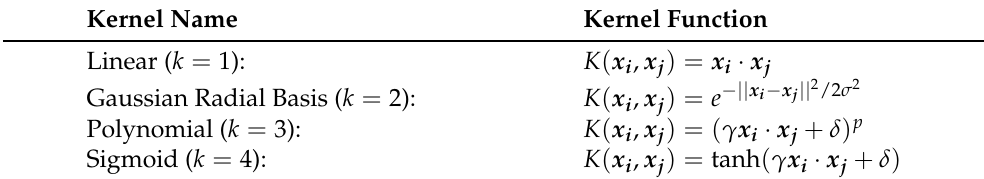
Table 1. Common kernel